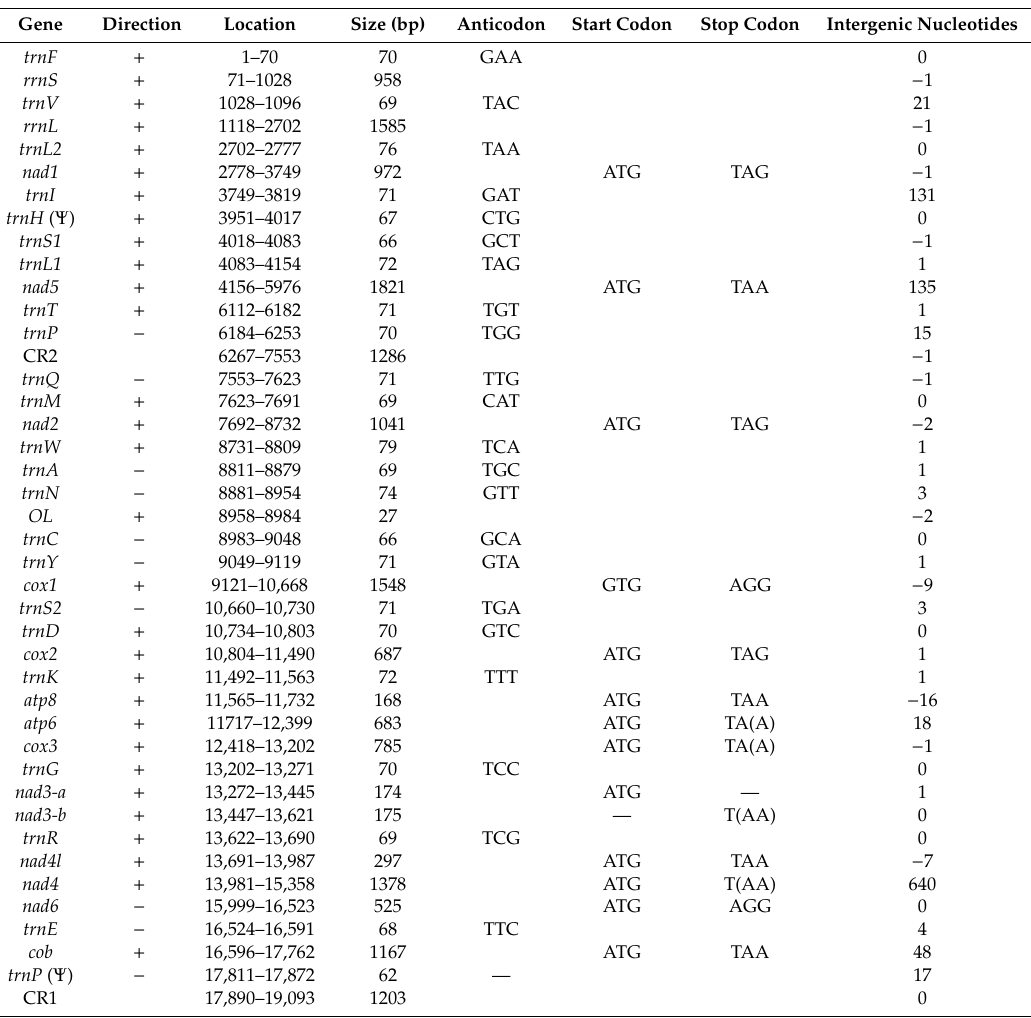
Table 1. Annotation of the complete mitogenome of P. m. peguense